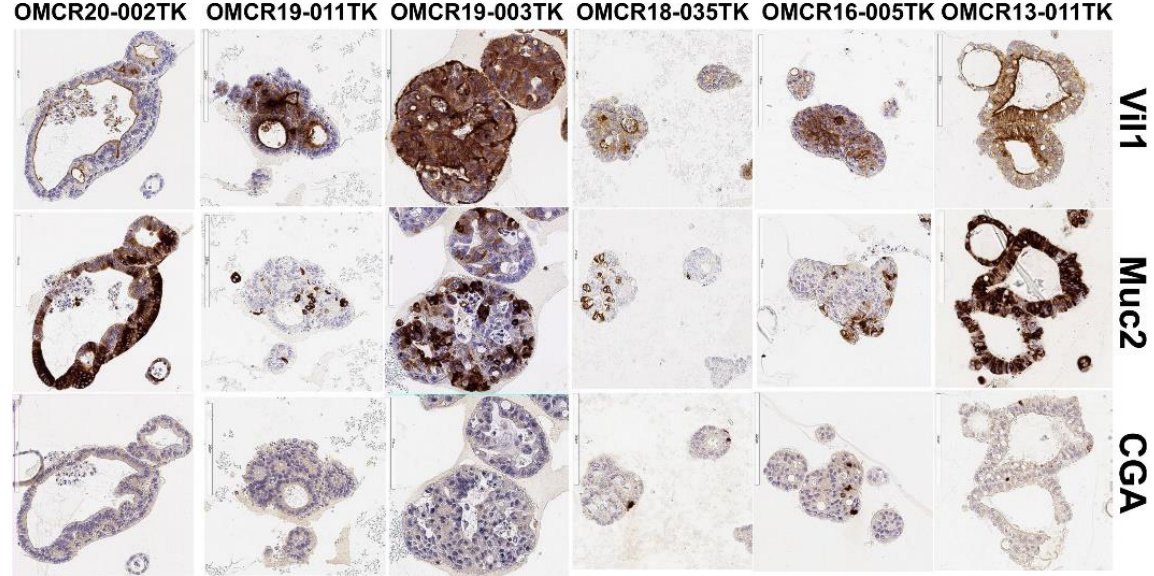
Figure 1. Villin1 (Vil1, enterocyte), Mucin2 (MUC2, goblet cell) and chromogranin-A (CGA, neuro- endocrine cell) marker expressions in some representative organoids. docrine cell) marker expressions in some representative